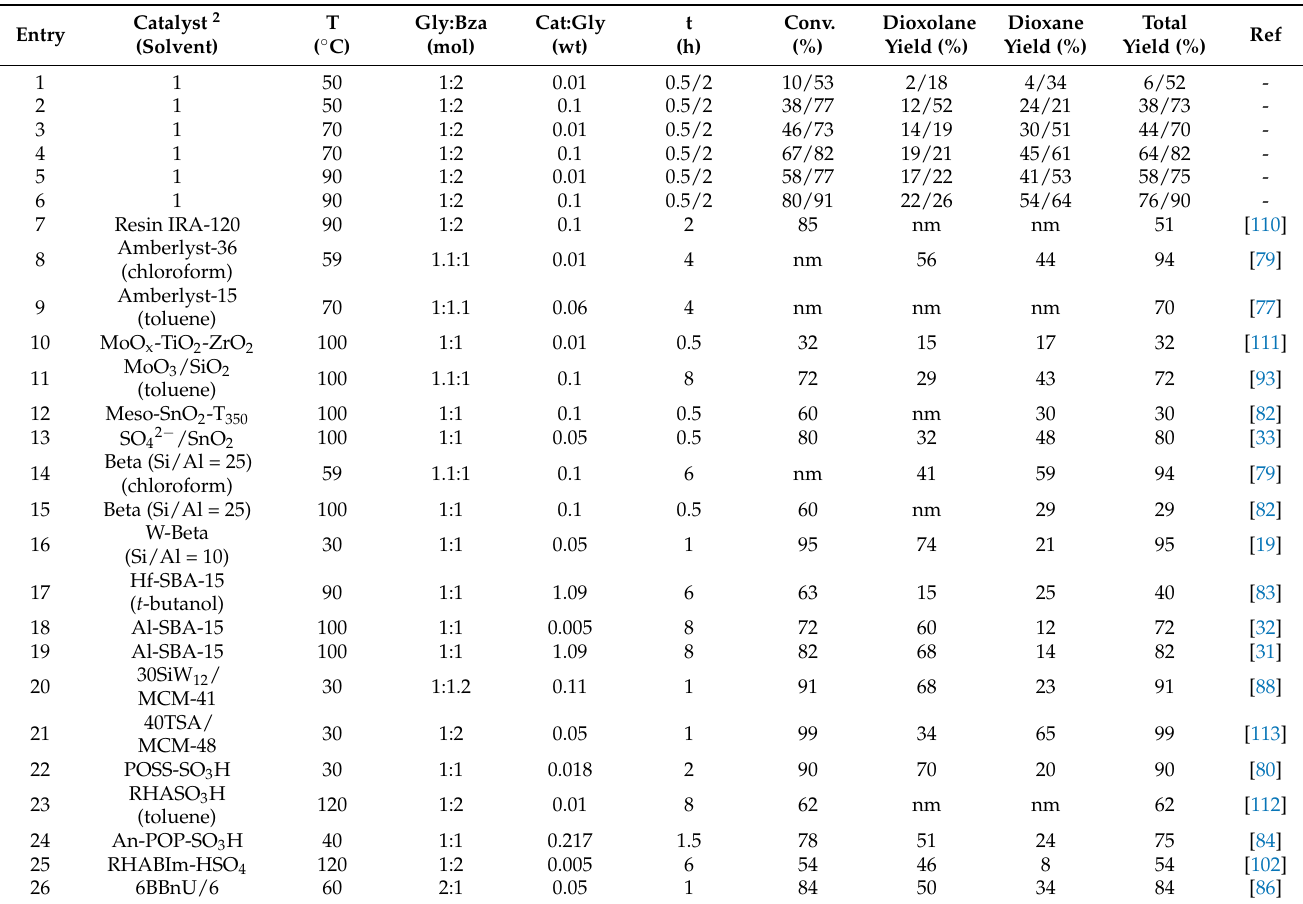
Table 2. Comparison of the results for 1 to literature data for other solid acid catalysts studied for the Bza/Gly reaction to heterobicyclic products 1